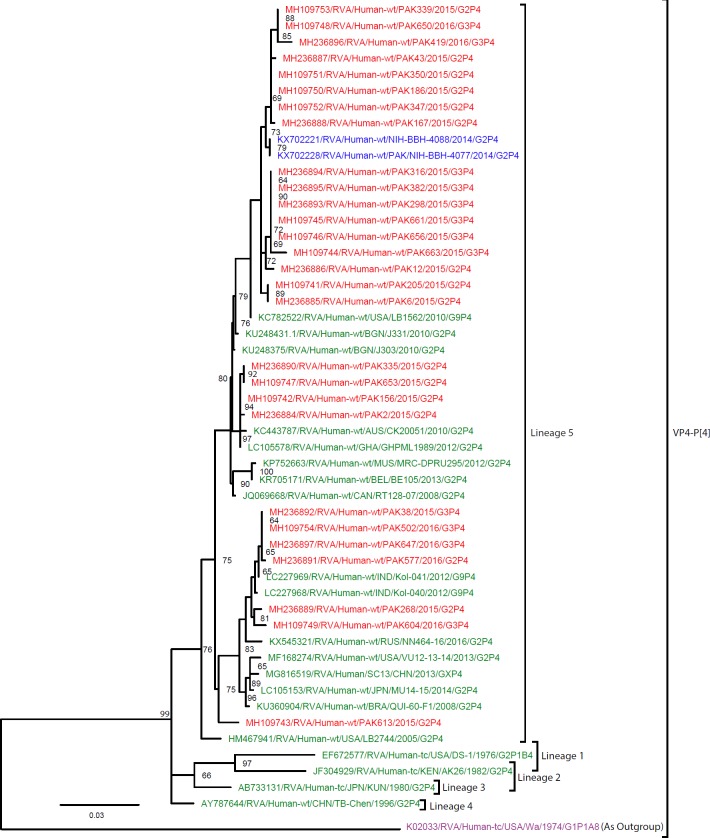
Maximum likelihood phylogenetic tree constructed from the nucleotide sequences of P[4]-VP4 strains and representative RVA strains with kimura-2-parameter model in MEGA program 6.0.Bootstrap values <60 are not shown. RVA strains sequenced in this study are represented by the red colour. Pakistani Strains reported in the previous studies are shown in blue. The out group strain is represented by purple colour while green shading represent strains isolated in all over the world. The RVA strains sequenced in this study and reference strains obtained from GenBank database are represented by Accession number, Strain Name, Country and year of Isolation. Scale bar: 0.03 substitutions per nucleotide. Scale bar: 0.03 substitutions per nucleotide.